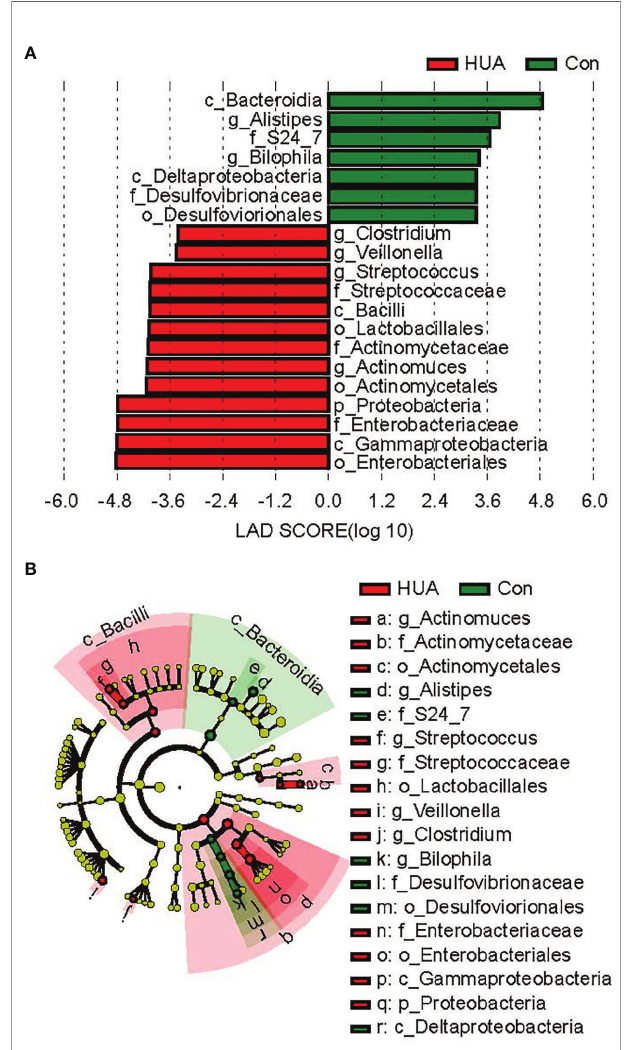
FIGURE 4 | Differential biomarkers in HUA and Con subjects by LefSe analysis ( a value = 0.05, logarithmic LDA score threshold = 2.0). HUA, hyperuricemia; Con, control. In the LEFse tree, different colors indicate different groups. Note colored in a group color shows an important microbe biomarker in the group and the biomark name will list in the upper right corner. The yellow notes represent the biomarker which do not show any importance in groups. (A) LDA plot of the differential bacterial by LEfSe analysis; (B) clodagram of the differential bacteria lby LEfSe